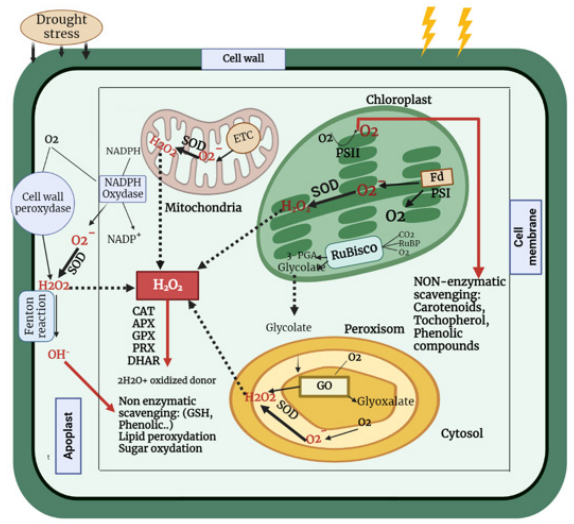
Figure 2. Scheme of ROS generation in various organelles during drought stress and their removal by enzymatic and non-enzymatic antioxidant mechanisms. Drought boosts ROS production in a variety of ways. During drought stress, low CO 2 levels in chloroplasts induce a reduction in NADP + regeneration via the Calvin cycle, resulting in an increase in electron leakage to O 2 to create O 2 − and, as a result, the production of more ROS. Furthermore, under a CO 2 -limited environment, photorespiration in C 3 plant leaf peroxisomes results in the production of phosphoglycolate. It stimu- lates ribulose1 and 5 bisphosphate (RuBP) oxygenation, which might result in enhanced H 2 O 2 gen- eration, owing to phosphoglycolate breakdown. The rate of mitochondrial respiration rises as the severity of the drought grows, to compensate for the reduced rate of ATP synthesis in the chloro- plast, resulting in greater ROS formation in the mitochondria. Scavenging of ROS occurs via en- zymes such as ascorbate peroxidase (APX), catalase (CAT), peroxiredoxins (PRX), glutathione pe- roxidase (GPx), and dehydroascorbate reductase (DHAR), as well as non-enzymatic scavenging via ascorbic acid, glutathione, and flavonoids, among others. 3.5. Molecular Responses: Stress Proteins, Transcription Factors, and Resistance Genes Plant responses to drought are extremely complex, as different morphological and physiological changes are mediated by complex signaling pathways that activate or in- hibit downstream processes [109]. Along with physiological and biochemical changes, drought also induces changes at the molecular level regarding the induction/modification of gene expression, activation of regulatory proteins, and initiation of plant signaling to counter the effect of these stressors [110]. External drought stimuli are perceived and sensed by sensors which are located on the plasma membrane or exist freely in the cytosol. These extracellular signals are then transformed into intracellular signals via a variety of secondary messages present in the cell including ROS, ABA, sugars, and calcium Ca 2+ ions, as well as transcriptional regula- tors with important roles in various signaling pathways [84,111]. After detecting stress, downstream signaling activates several stress-responsive genes. There are two types of stress-responsive genes: (1) genes that encode protective proteins providing direct protec- tion of the plant cell from stress such as heat shock proteins (HSPs) or chaperones, LEA proteins, osmoprotectants, ROS detoxifying enzymes, aquaporins (AQP), and transport- ers (sugars and proline), and (2) regulatory genes that enable stress signal perception and transduction within plant cells through general and specific regulatory-signaling path- ways including transcription factors, mitogen-activated protein kinase (MAPK), and cal- cium-dependent protein kinase (CDPK) [109,111]. In addition, the expression of various stress-related genes can be controlled by tran- scription factors. TFs are able to bind to DNA sequences and activate and/or repress